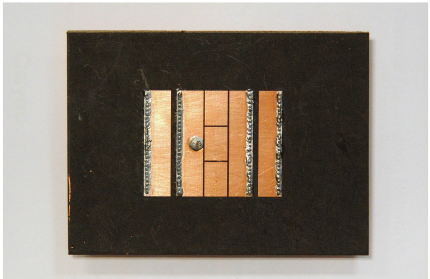
Figure 2: Photo for the 4-element Yagi array of quarter-wave patch antennas with the geometry shown in Figure 1.